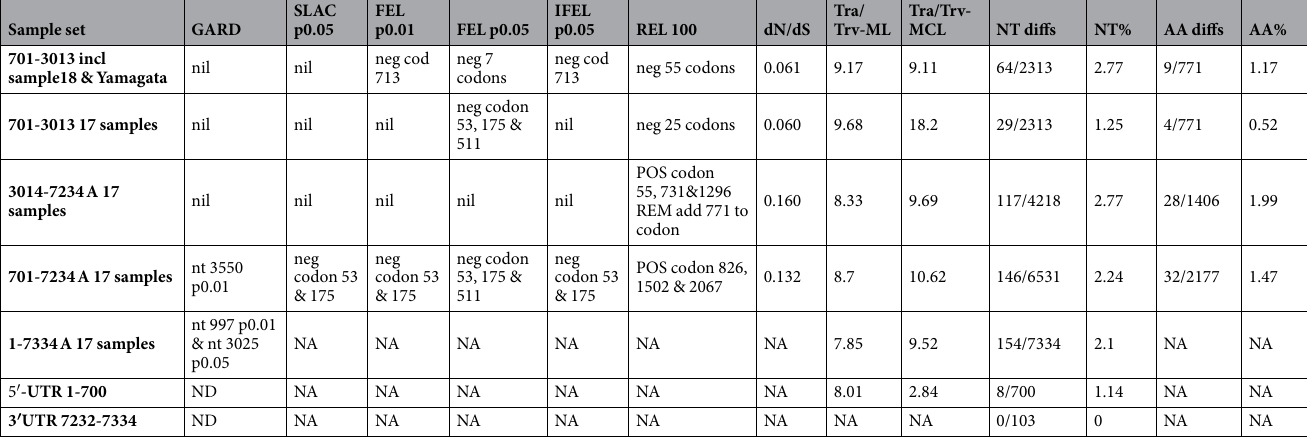
cluster/recombinant and not the AB759207 cluster/recombinant. Nevertheless, based on BLAST comparison to all sequences available in the NCBI databases, the Yamagata 2011 lineage(s) of viruses are the closest related to our Australian HPeV3 outbreak viruses in the region up to approximately nucleotide 3100 (the capsid encoding region) and consequently are included in our initial phylogenetic analysis. In any event, GARD analysis of the full sequence and the coding region from nucleotide 701 to 7231 of our Australian HPeV3 virus sequences, (excluding CS-HP-16018 as mentioned above), indicated possible sites of recombination at nucleotide 997 and nucleotide 3025 or 3550. The level of significance only reached p = 0.01–0.05 and likely reflects the impact of slight differences in evolutionary rates among the regions derived from previous recombination event(s) 1 . The